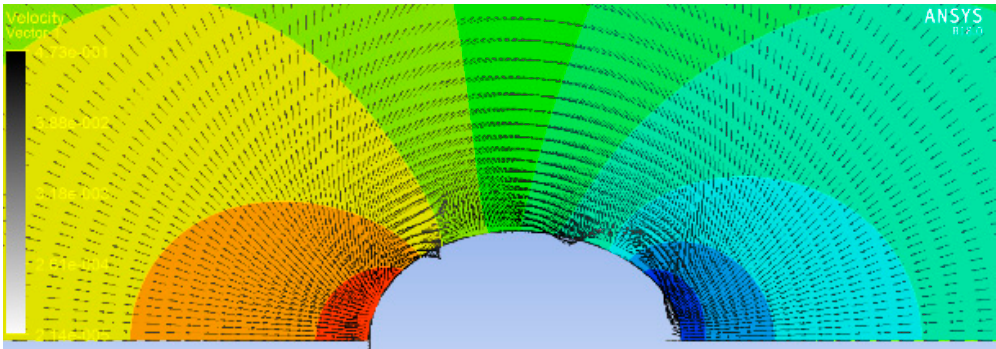
Figure 13. The instantaneous contours of velocity when t = 1.0 s.